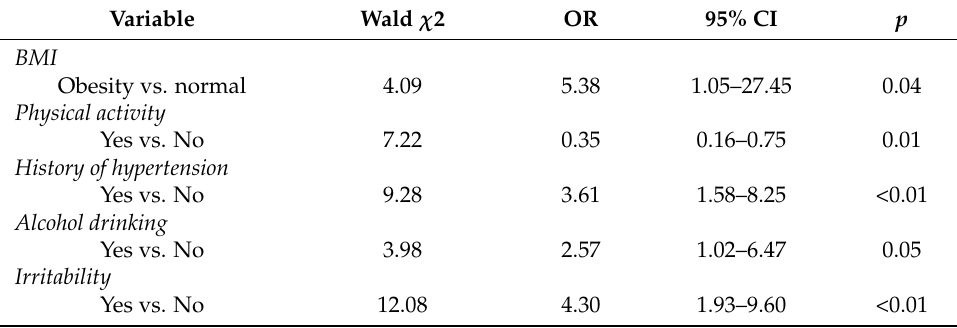
Table 7. Multivariate logistic analysis of CVD